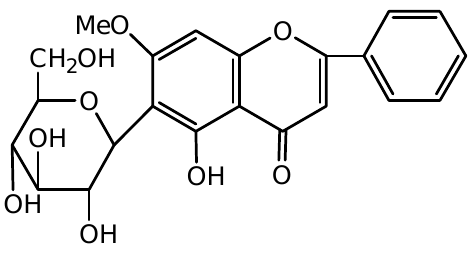
Figure 1 . Structure of Compound 1